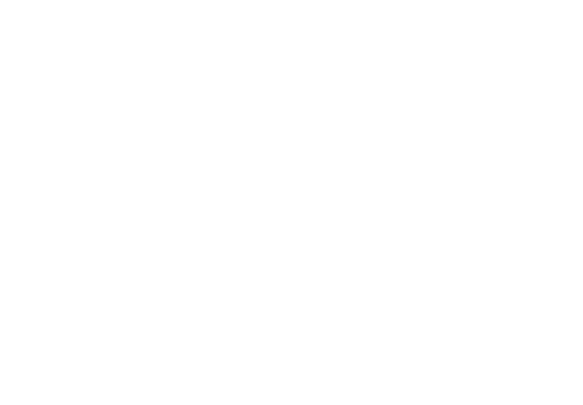
Figure 17. Representation of the structure of the adrenergic β 2 receptor (sourced from the Protein Data Bank, PDB code: 7DHI [129], method: cryo-EM, resolution: 3.26 Å ). The image was created and rendered with MOE.